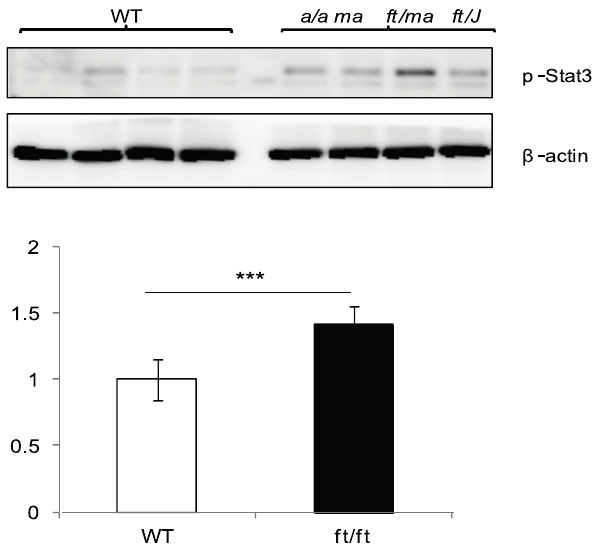
Figure 5. Stat3 phosphorylation in a/a ma ft/ma ft/J mouse epidermis. Protein skin extracts from P5 WT and a/a ma ft/ma ft/J (ft/ ft) mice were submitted to WB, performed with rabbit anti-phospho- Stat3 and anti-actin antibodies, and detected by chemiluminescence. Quantification of p-Stat3 expression normalized to b -actin is represent- ed in histograms. Statistical differences were calculated with the student T-test (***p , 0.001). DTT for 1 hr at 4 u C; the insoluble fraction was obtained after centrifugation (10 min, 12000 rpm, 4 u C) [22]. Proteins were assayed by Bradford method. Lysates were fractionated on SDS- PAGE gels, electrotransferred onto PVDF Immobilion H -P Trans- fer membranes (Millipore, Temecula, CA) and stained with Ponceau S to evaluate protein loading. Membranes were blocked